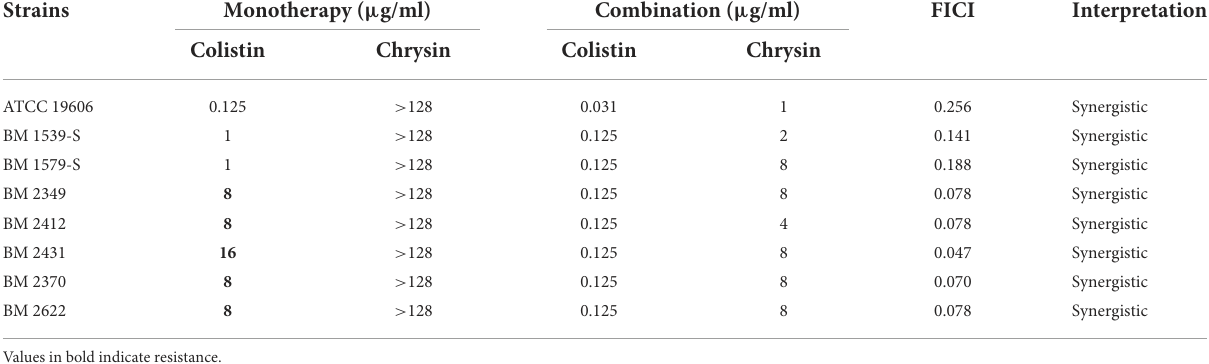
TABLE 1 Fractional inhibitory concentration index (FICI) for colistin/chrysin combinations against Acinetobacter baumannii . Strains